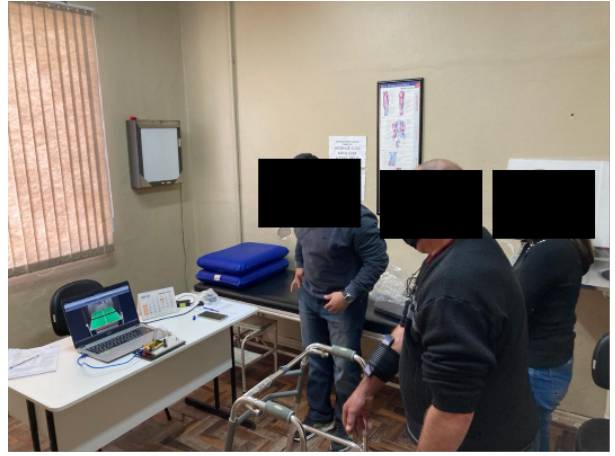
Figure 7. Test session of the solution. Source: Author